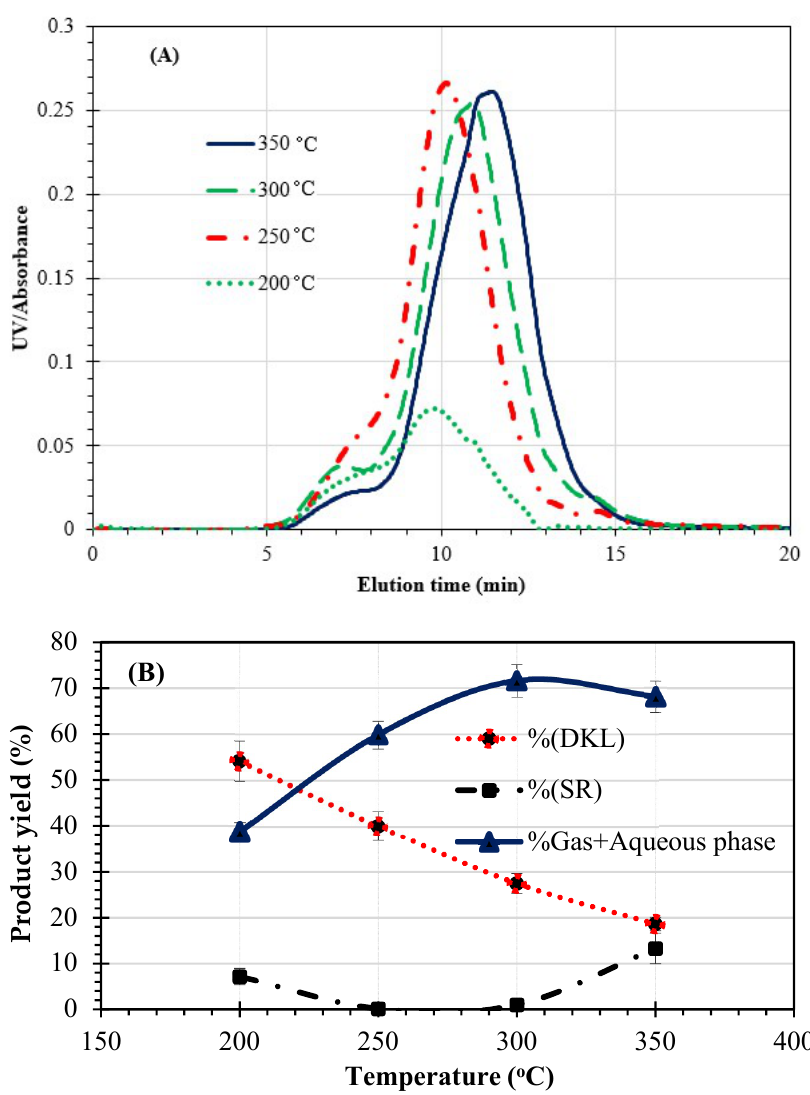
Figure 2. Effects of temperature on molecular weight distribution of DKLs ( A ) and reaction yields ( B ) after treatment of black liquor at temperatures ranging from 200 to 350 ◦ C for 1 h.